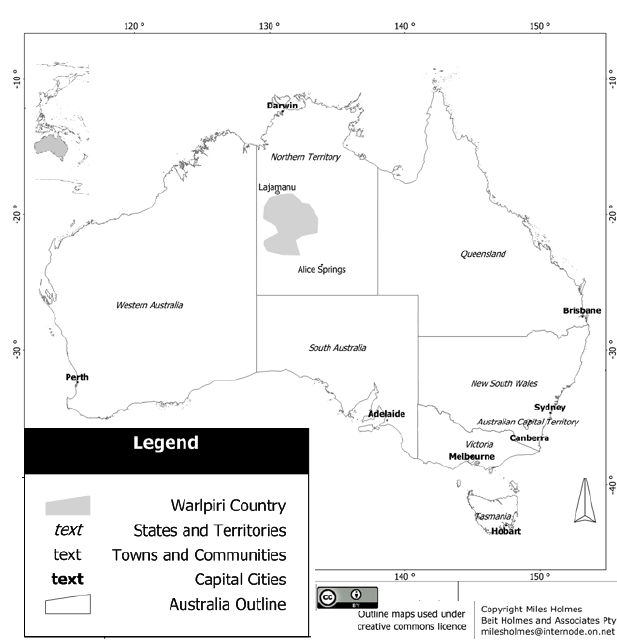
Fig. 1. Map of Warlpiri country within